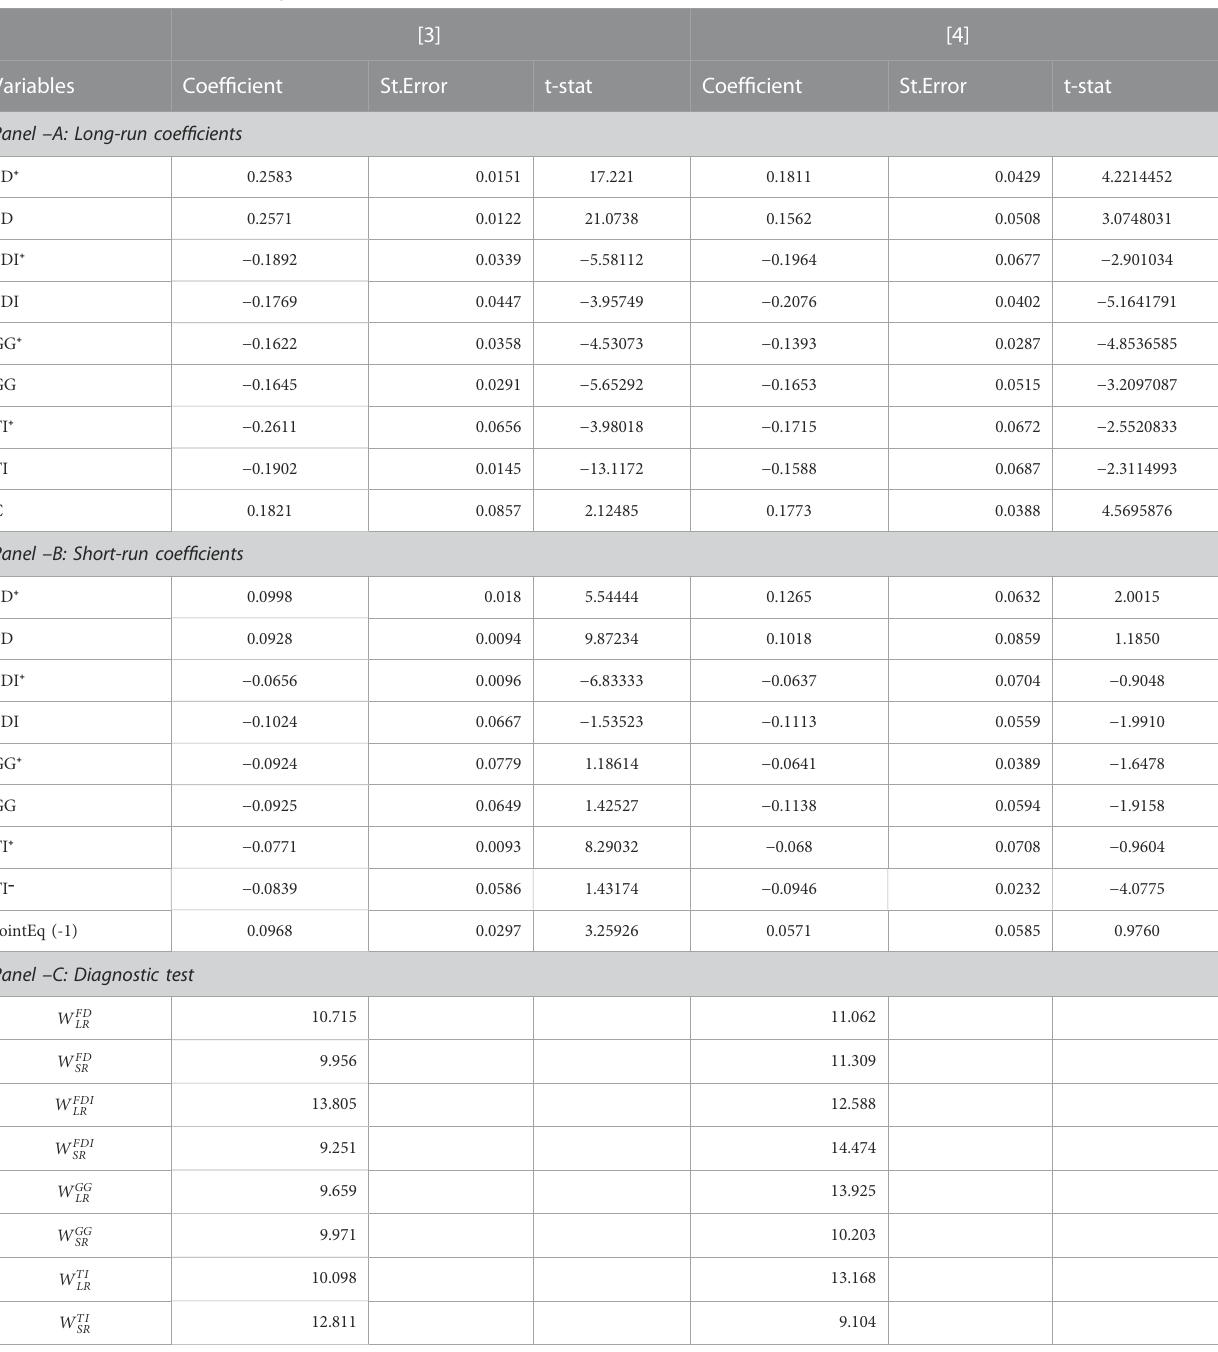
TABLE 11 Asymmetric assessment: ED| FD +/- , FDI +/- , GG +/- , TI +/-